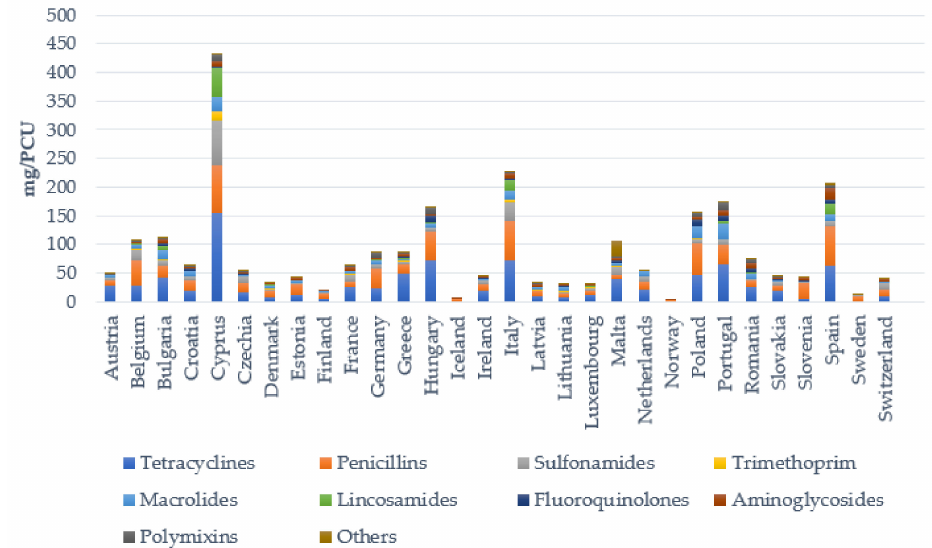
Figure 1. Sales of the various antimicrobial classes in mg/PCU for use in livestock in 30 European countries in